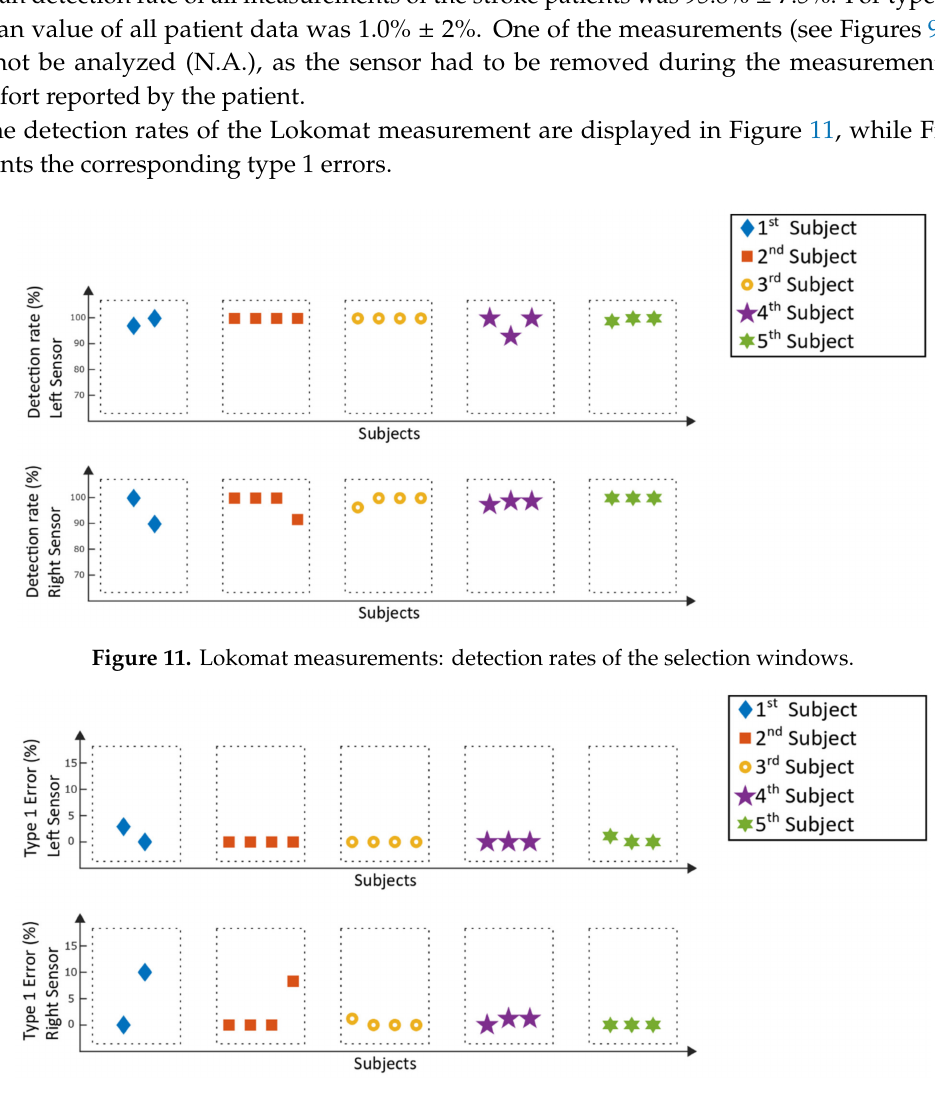
Figure 12. Lokomat measurements: type 1 errors of the selection